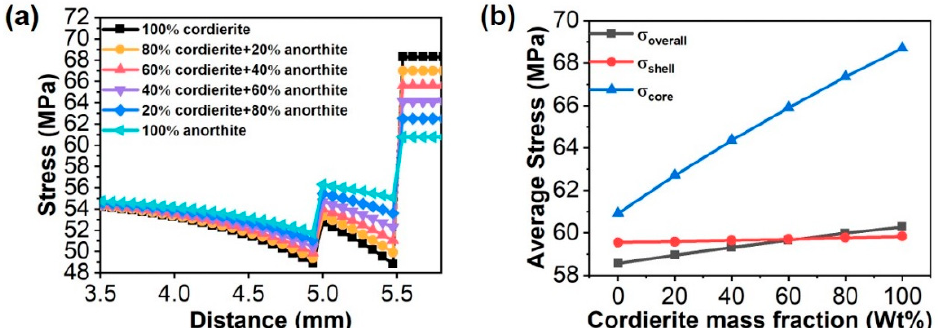
Figure 4. ( a ) Path I stress distribution curves for different mineral compositions; and ( b ) Average stress of the core, shell, with the entire model composed of different minerals.